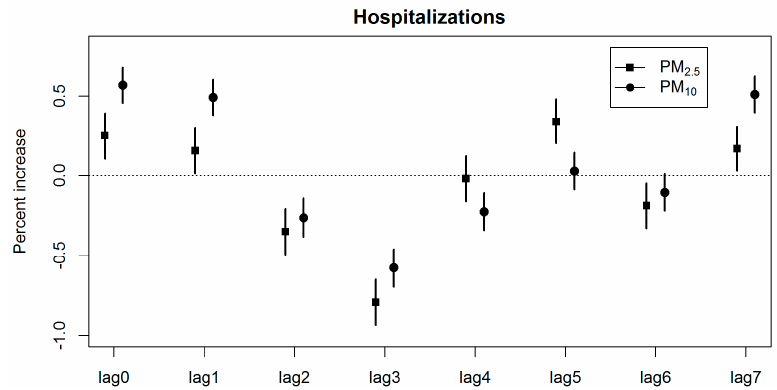
Figure 2. Percentage increase in IHD hospitalizations (95% CI) associated with a 10 μ g/m 3 increase in PM 2.5 and PM 10 concentrations from lag 0 to lag 7 across all seasons.